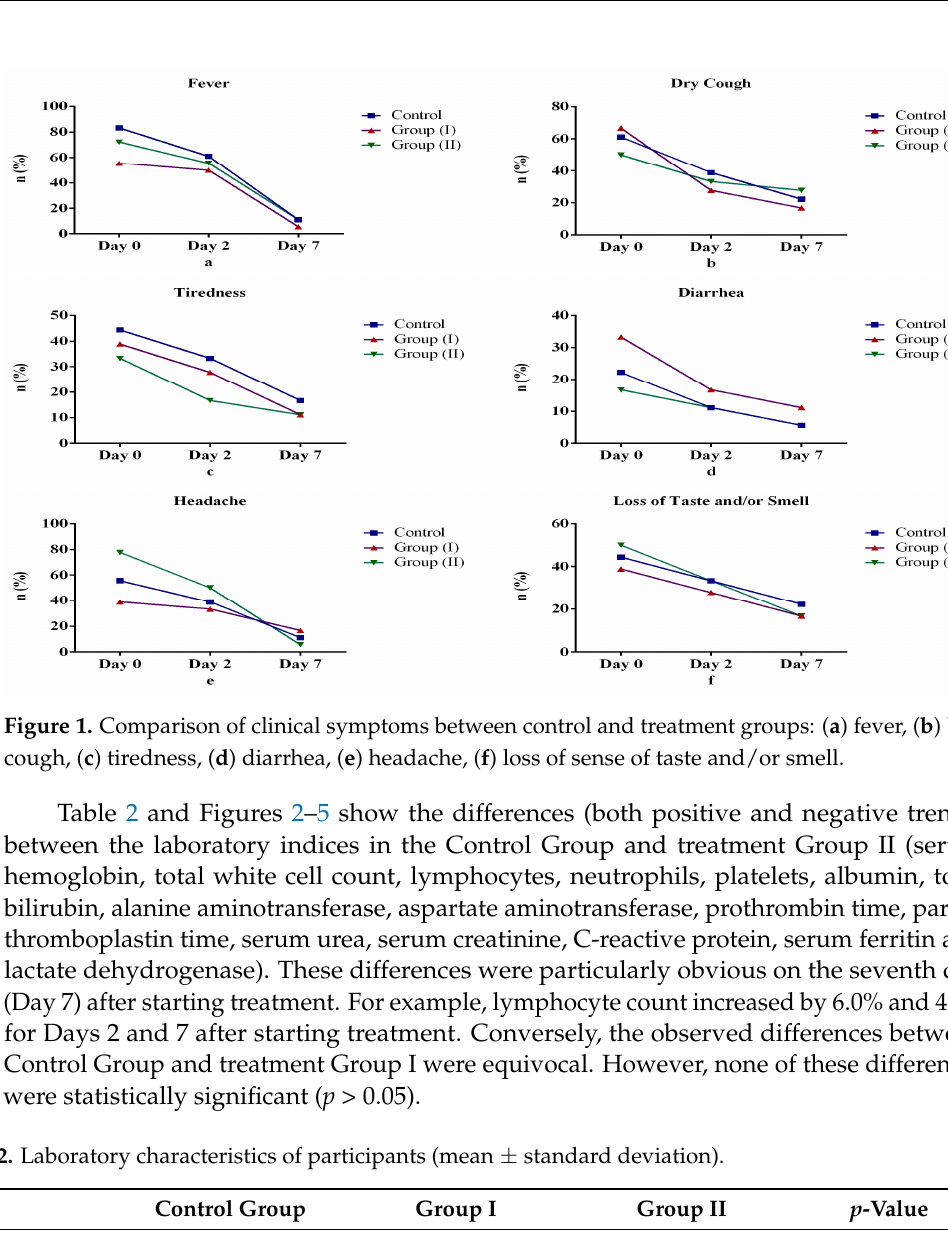
Table 2. Laboratory characteristics of participants (mean